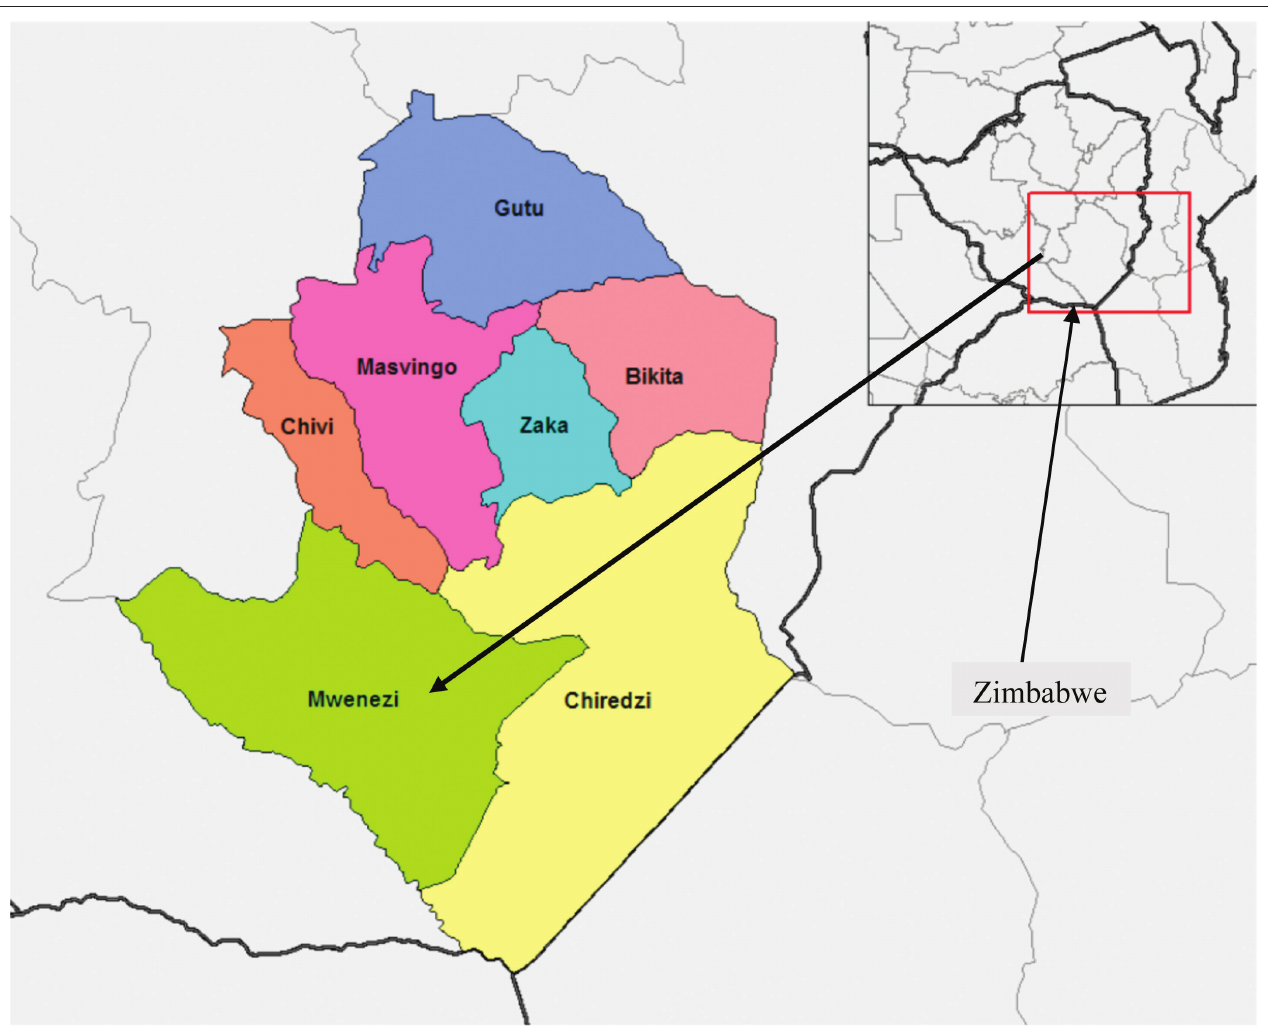
FIGURE 1: Map for Mwenezi district,